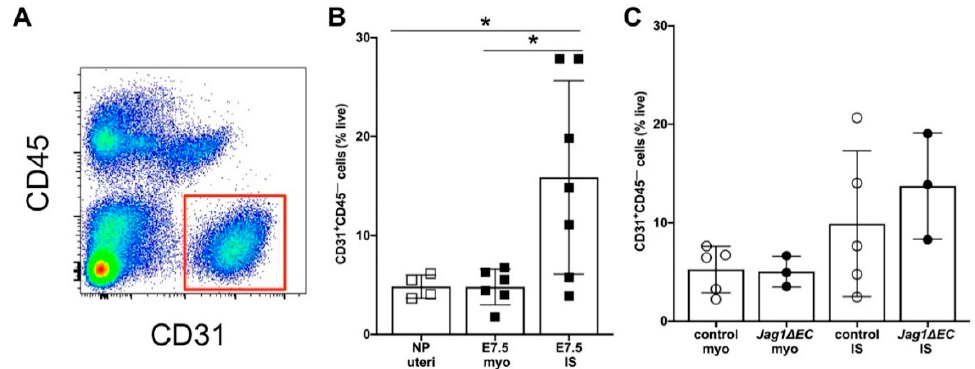
Figure 8. EC-specific loss of Jag1 does not impact the frequency of CD31 + ECs in implantation sites. ( A ) Representative dot plot of flow cytometry (FCM) data showing gating strategy to identify CD31 + CD45 – EC populations in implantation sites from wild-type C57BL/6 mice at E7.5. ( B ) Results of FCM analysis to assess CD31 + CD45 - cell populations in uteri from nonpregnant C57BL/6 mice, and in the myometrium and implantation sites from pregnant C57BL/6 mice at E7.5. The percentage of CD31 + CD45 - ECs is significantly higher in implantation sites compared to the myometrium or nonpregnant uteri. ( C ) Results of FCM analysis to determine the percentage of CD31 + CD45 - ECs in